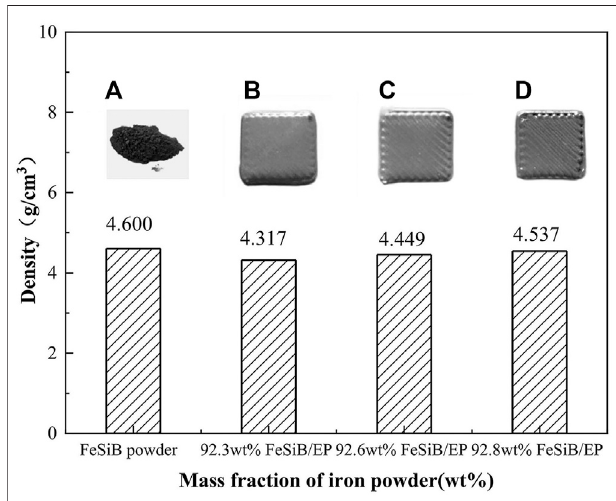
FIGURE 2 | The density of printing parts and the photos of printing samples with different iron powder content: (A) FeSiB powder, (B) 92.3 wt% FeSiB/EP, (C) 92.6 wt% FeSiB/EP, and (D) 92.8 wt% FeSiB/EP